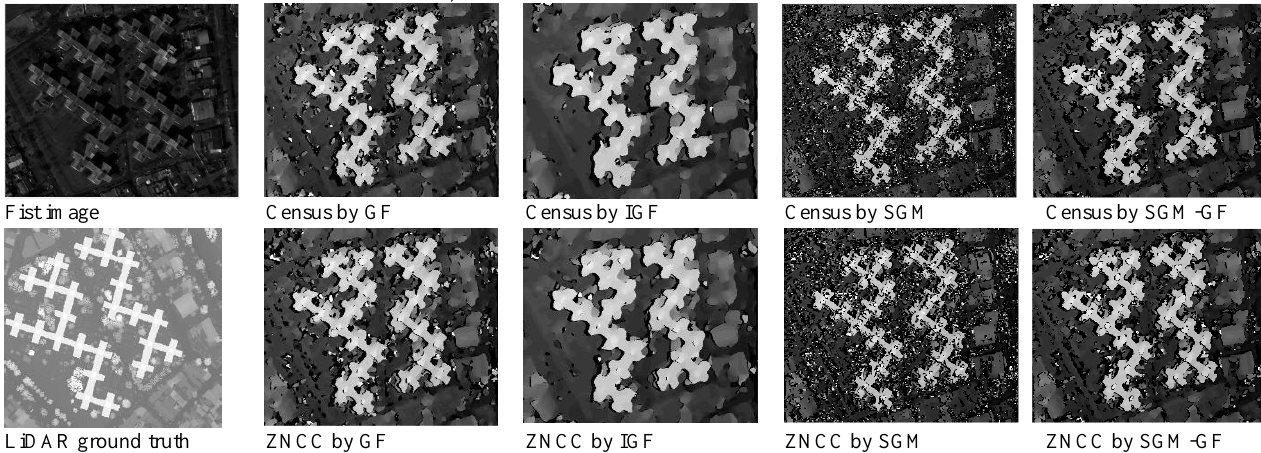
Figure 5: The comparison of the generated disparity maps from the selected cost aggregation methods. First and second raw include the result for Census and ZNCC cost functions,